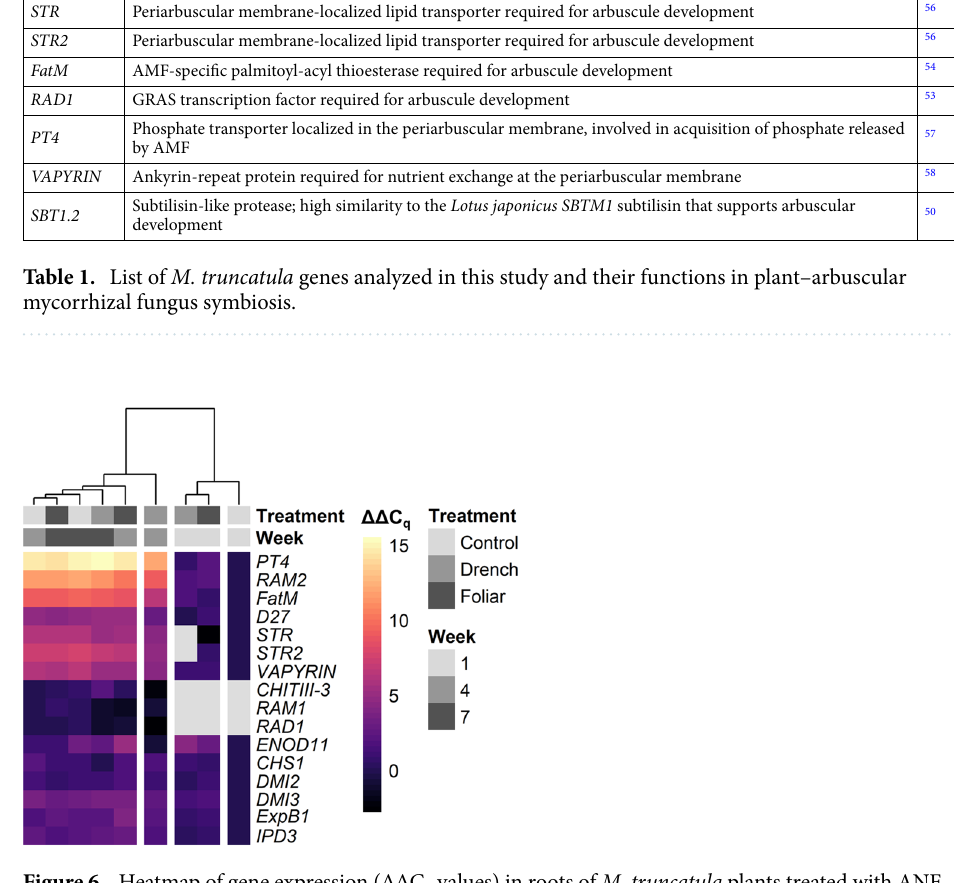
Figure 6. Heatmap of gene expression (ΔΔC q values) in roots of M. truncatula plants treated with ANE foliarly or via drench in comparison to control treatments at weeks 1, 4 and 7 of growth following R. irregularis inoculation. Gray data points indicate expression levels below the limit of detection. The dendrogram shows hierarchical clustering of the treatments at each week calculated using the complete-linkage method. Expression was normalized to the control at week 1, or to the control at week 4 for genes where expression was below the limit of detection at week